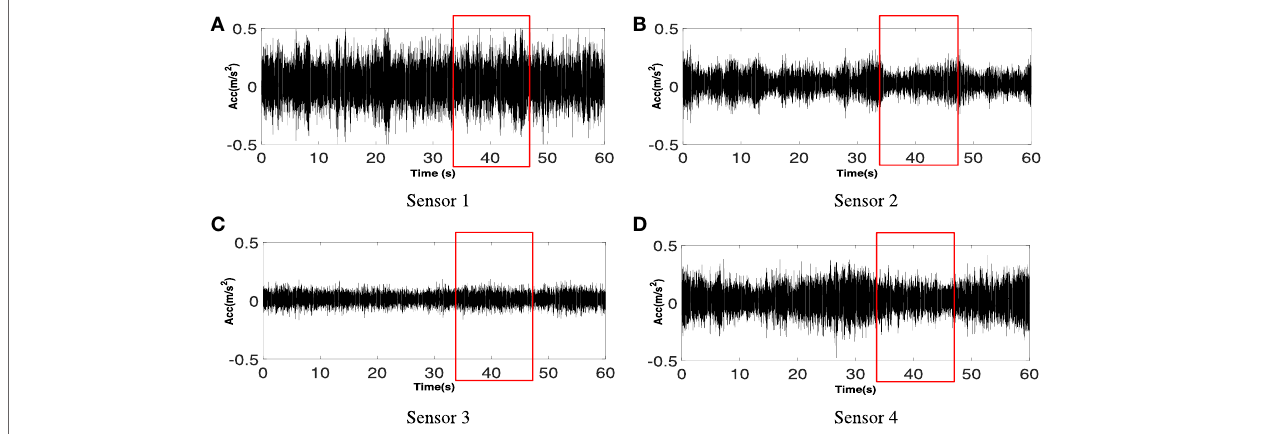
FIGURE 4 | Vibration signals for 60s collected from 4 sensors deployed on the 11th floor as shown in Figure 3 . The train passed by the building at 32–48s (as red boxes show). The building vibration due to train is not obviously visible due to the background noise. (A) Sensor 1. (B) Sensor 2. (C) Sensor 3. (D) Sensor 4.